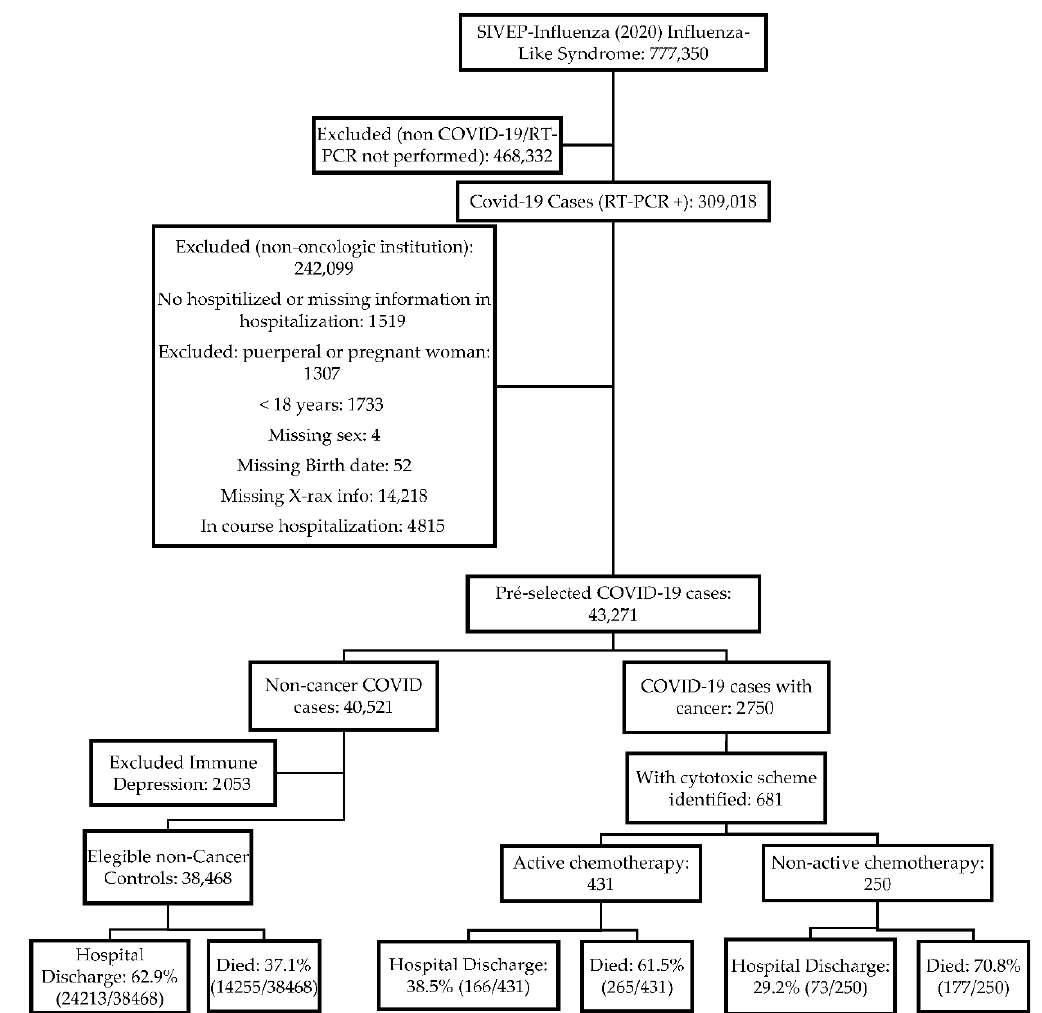
Figure 1. Data flowchart for the analysis process.